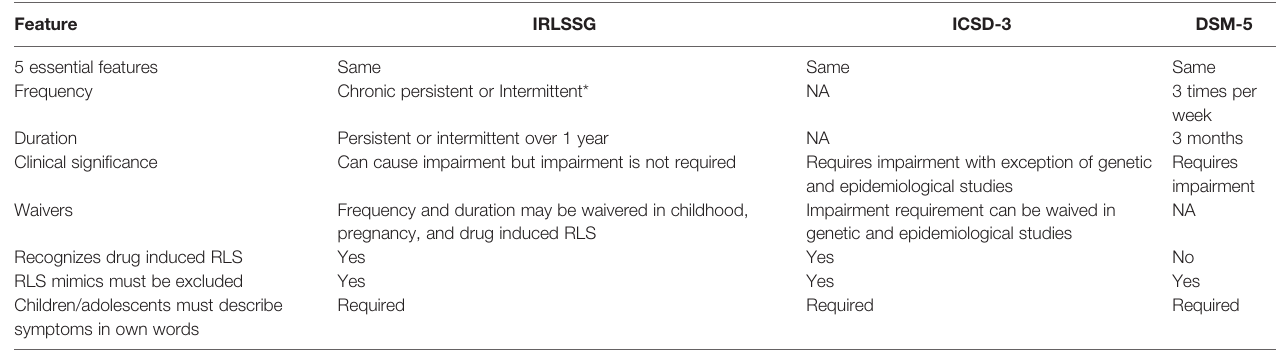
TABLE 1 | Criteria for restless legs syndrome (RLS) by different organizations.